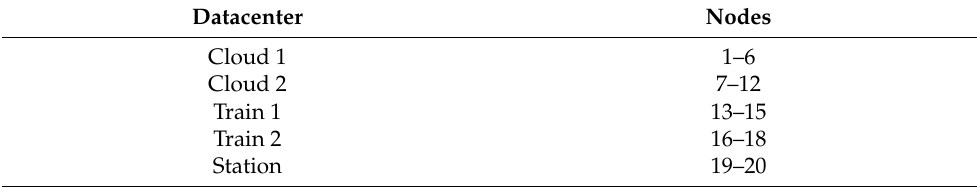
Table 2. Nodes distribution among